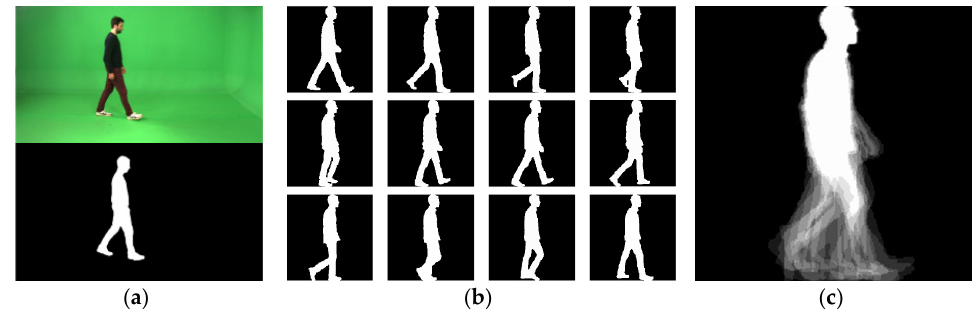
Figure 1. Example of ( a ) background subtraction, ( b ) binary silhouettes and ( c )